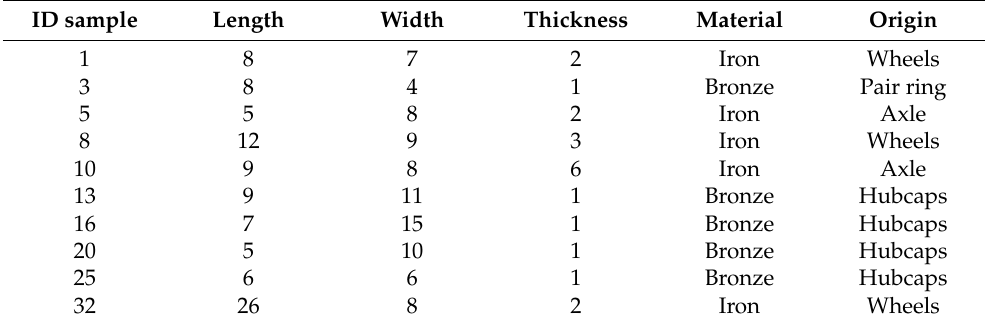
Table 1. List of the analyzed fragments shown in the columns in order: ID of the samples, length, width, thickness, material, and origin. Dimensions were measured in